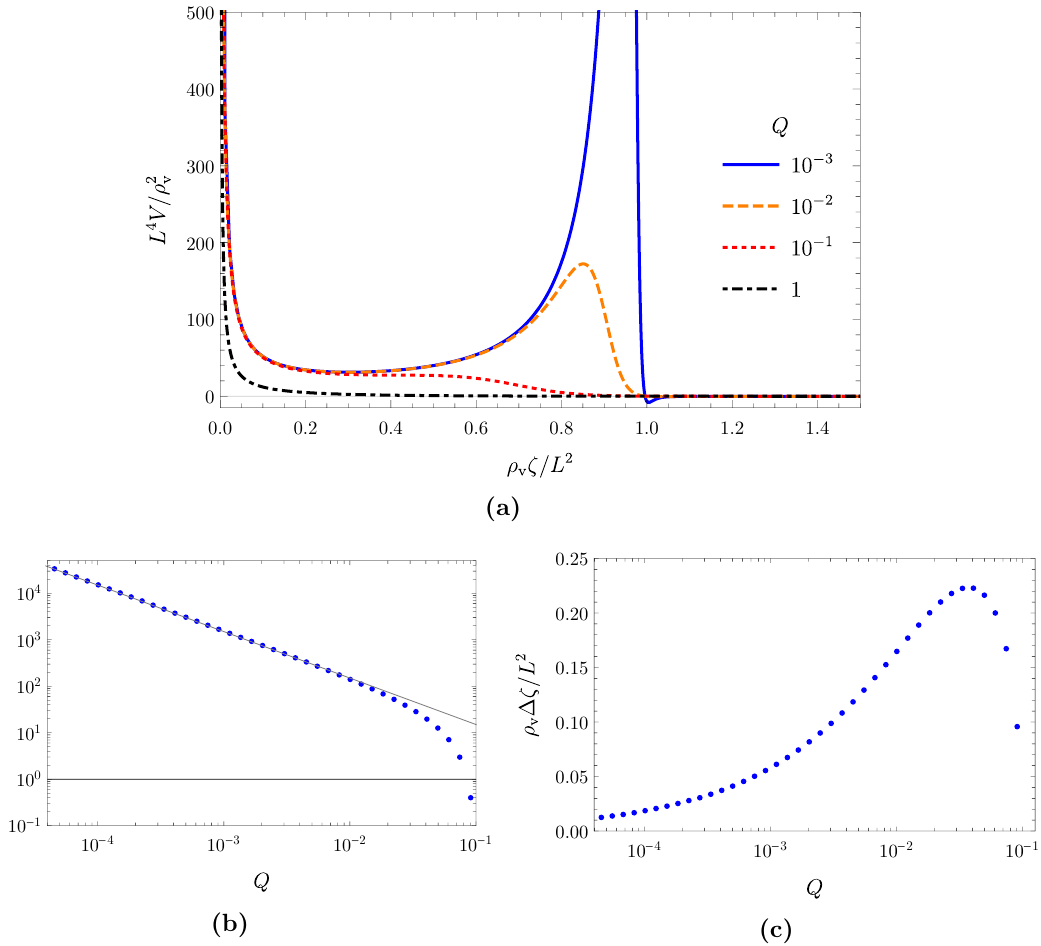
Figure 7. (a) The Schr(cid:127)odinger potential V ( (cid:16) ) de(cid:12)ned in eq. (4.5), in units of (cid:26) 2 =L 4 , as a function v of (cid:16) , in units of L 2 =(cid:26) v , for the (cid:13)uctuation (cid:26) 0 with Q = 10 (cid:0) 3 ; 10 (cid:0) 2 ; 10 (cid:0) 1 ; 1 (solid blue, dashed orange, dotted red, dash-dotted black). The asymptotic behaviours are given in eq. (4.9): as (cid:16) ! 0 an in(cid:12)nite barrier appears, while V ! 0 (cid:0) as (cid:16) ! 1 . For small Q a peak appears at (cid:12)nite (cid:16) , and hence a potential well, with local minimum at V > 0. As Q increases, the peak shrinks and broadens, and eventually disappears when Q (cid:25) 0 : 0977. (b) Logarithmic plot of the peak’s height, (cid:1) V , de(cid:12)ned as the di(cid:11)erence in V between the top of the peak and the bottom of the potential well, in units of (cid:26) 2 =L 4 , as a function of Q . The grey line is (cid:1) V = 3 (cid:26) 2 = (2 QL 4 ), which is a good v v approximation for Q . 10 (cid:0) 2 . (c) The full width at half maximum of the peak, (cid:1) (cid:16) , in units of L 2 =(cid:26) v , as a function of Q